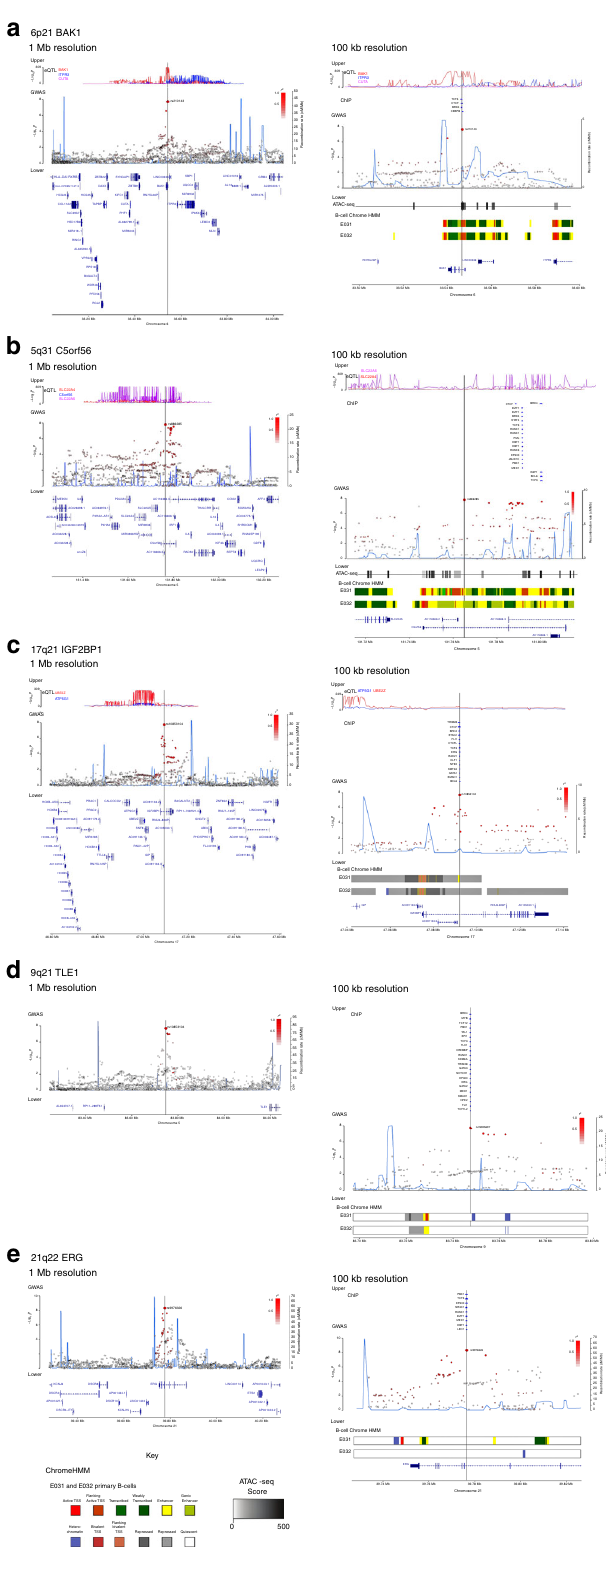
Fig. 2 Regional plots of association results and recombination rates for the newly identi fi ed risk loci. a 6p21 (rs210143), b 5q31 (rs886285), c 17q21, d 9q21.3 (rs76925697), e 21q22 (rs9976326). Loci are shown at both 1Mb (left) and 100kb (right) resolutions. Upper panes show FDR corrected eQTL P -values extracted from the Blood database; ChIP transcription factor binding sites shown as blue bars. GWAS pane shows plots show association − log P -values (left y-axis) of SNPs shown according to their chromosomal 10 positions (x-axis). Light blue line shows recombination rates in (cM/Mb) from UK10K Genomes Project (right y-axis). Lead SNPs are denoted by large circles labelled by rsID. Colour intensity of each symbol re fl ects LD, white (r 2 = 0), dark red (r 2 = 1.0). Genome coordinates are from NCBI human genome GRCh37. Lower pane shows chromatin-state segmentation tracks (ChromHMM) from primary B cells and gene positions from Gencode v27 comprehensive gene annotation. Where no signi fi cant results were obtained upper and lower panes